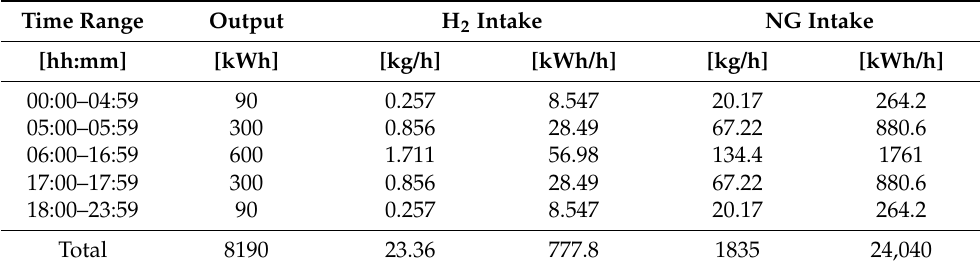
Table 5. CHP hourly electrical output and fuel intake for a H 2 volumetric percentage of